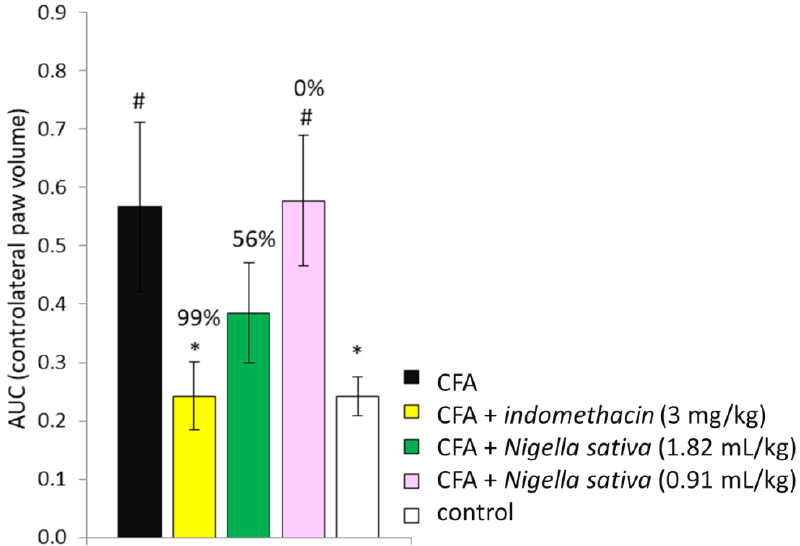
Figure 4. Effect of Nigella sativa oil on % inhibition of arthritis in CFA-induced arthritic rats. CFA- immunized rats (day 0) received Nigella sativa oil (1.82 or 0.91 mL/kg), indomethacin (3 mg/kg) or CFA-immunized rats (day 0) received Nigella sativa oil (1.82 or 0.91 mL